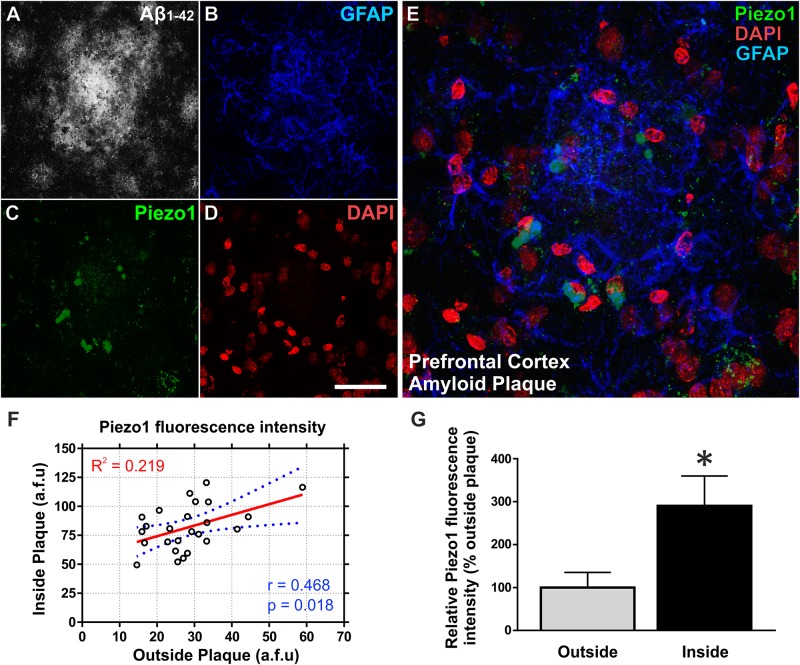
Aβ1-42 pathology in vivo upregulates Piezo1 expression in astrocytes surrounding amyloid plaques. 18-Month old TgF344-AD rat brains were immunofluorescently stained for (A) conformation-specific Aβ1-42, (B) GFAP, (C) Piezo1 (N-terminal antibody), and (D) DAPI. Scale bar = 40 μm. (E) High magnification (100× objective) z-stack projections of prefrontal cortex amyloid plaques reveal an upregulation of GFAP in reactive astrocytes surrounding the amyloid plaque. Piezo1 protein is also upregulated in a proportion of astrocytes in and around the core of the plaque. Piezo1 appears localized predominantly to the perinuclear compartment of Aβ1-42 reactive astrocytes. (F) Astrocytic Piezo1 fluorescence intensity was calculated for astrocytes inside the amyloid plaque versus astrocytes located 200–500 μm away from any noticeable plaque deposits. Piezo1 fluorescence intensity was averaged for six astrocytes “inside” and six astrocytes “outside” the plaque and 25 images from the frontal cortex of 18 m TG rats (n = 6) were analyzed. There was no correlation (Pearson r = 0.468) between Piezo1 expression inside versus outside amyloid plaques. (G) However, on average there was a 190% increase in Piezo1 expression in astrocytes within the plaque core (Inside) versus astrocytes at least 200 μm away from the edge of any amyloid plaque (Outside). A two-tailed paired t-test was performed. ∗Represents a statistically significant difference (p < 0.001) inside versus outside of the plaque.